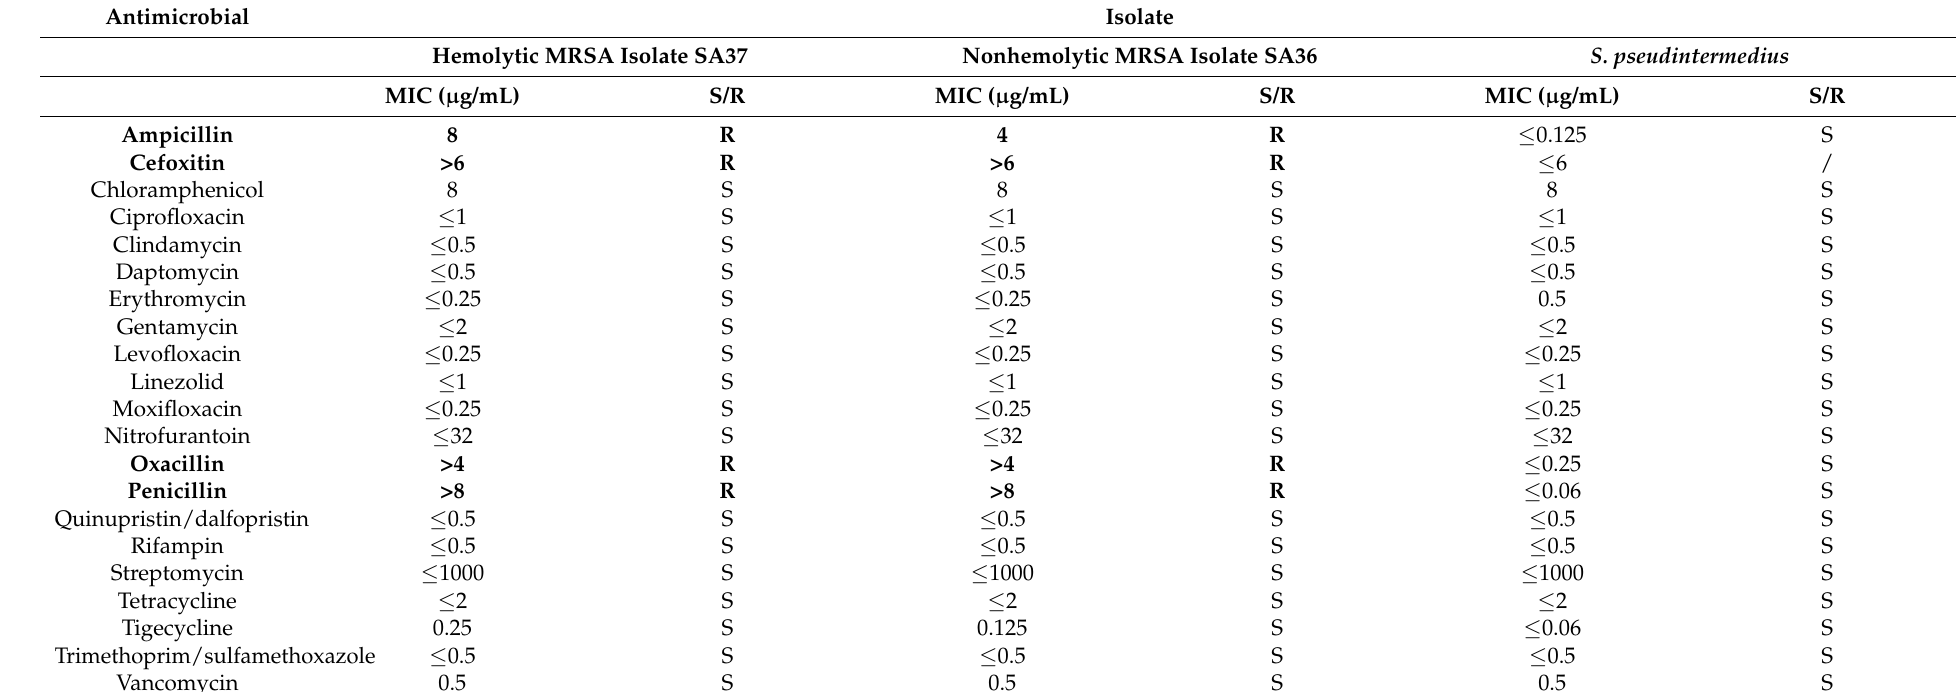
Table 1. Results of antimicrobial susceptibility testing for three Staphylococcus